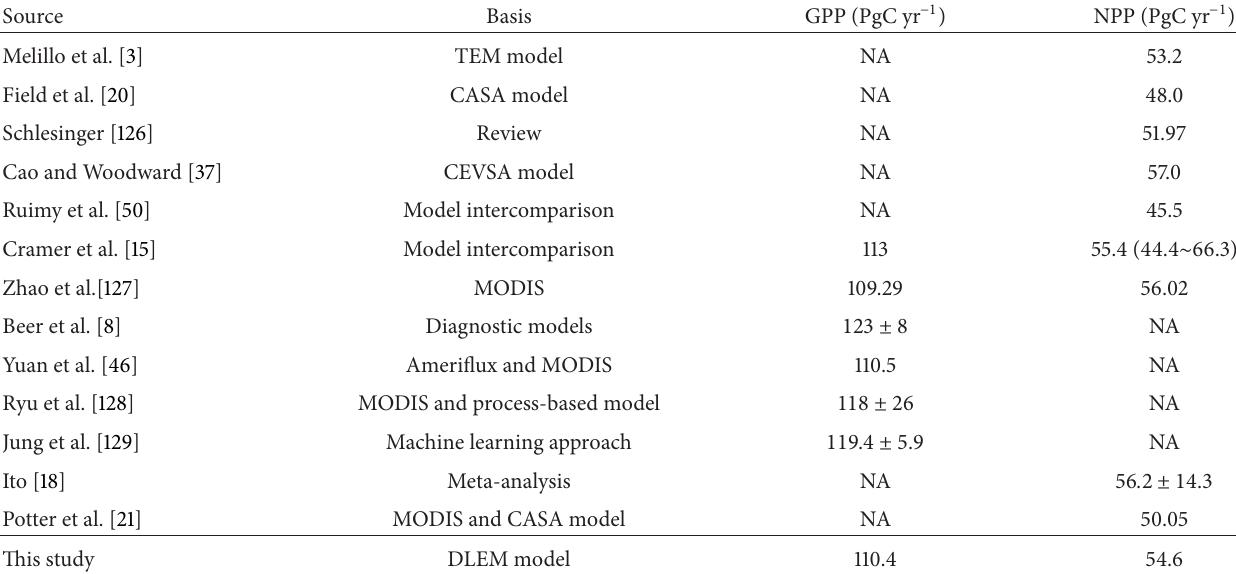
Table 1: Published values of global terrestrial GPP and NPP based on observations, satellites, and/or process-based